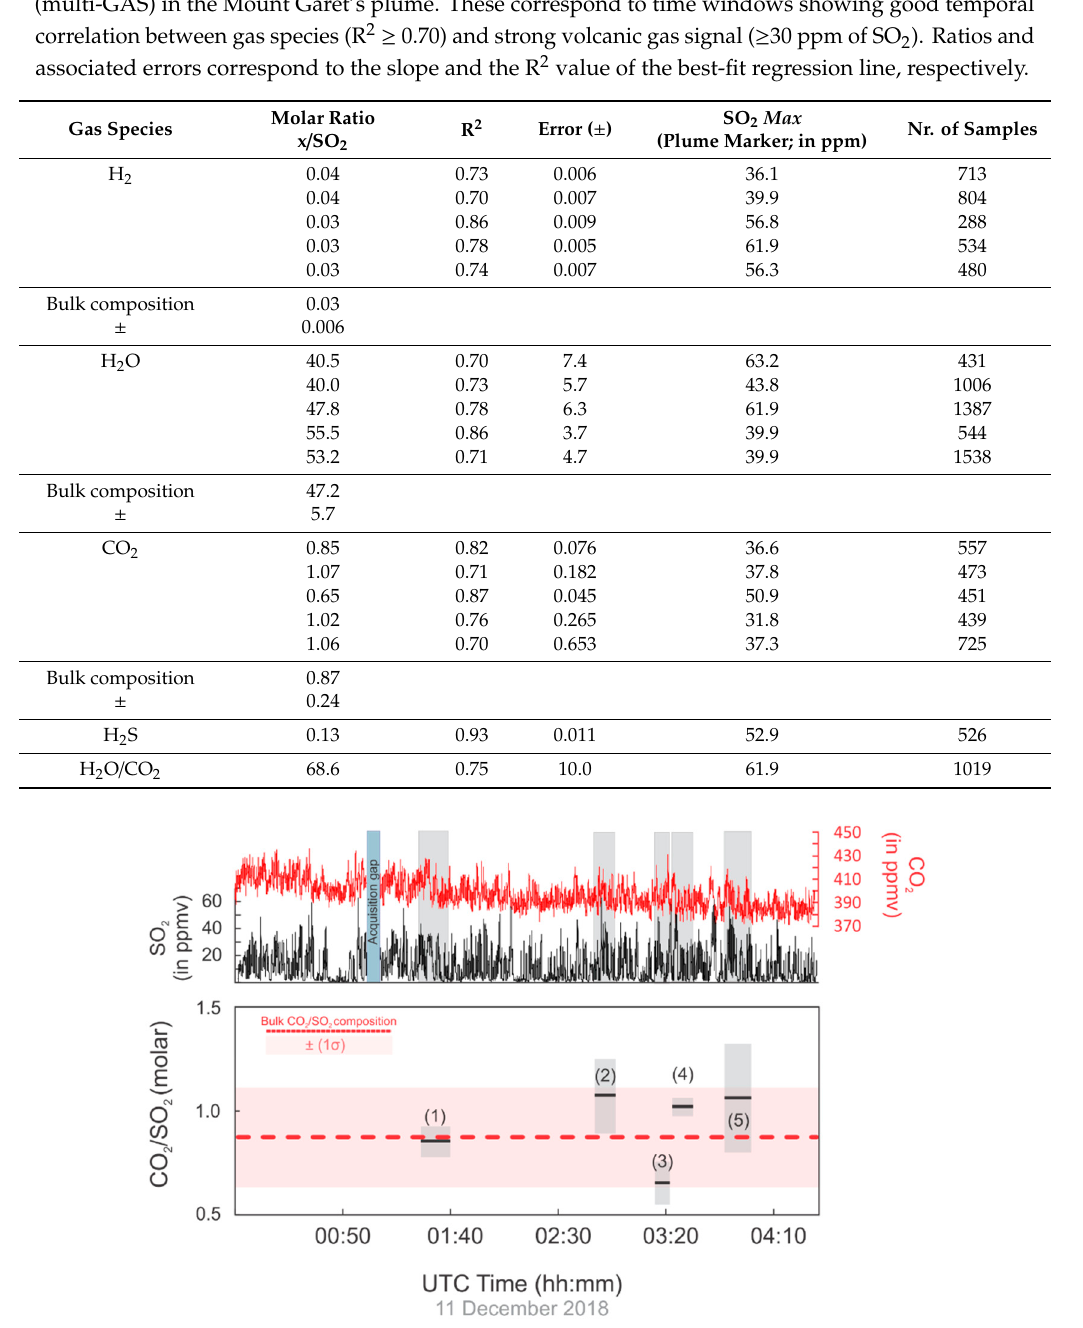
Figure 2. CO 2 / SO 2 mixing ratios estimated across the 4-h survey period. At the bottom, the dash red line represents the regression analysis of all 5 CO 2 / SO 2 ratios (Table 1) combined. SO 2 and CO 2 concentration (in ppmv) time series at the top illustrates plume conditions at which individual ratios were calculated. Note that CO 2 / SO 2 ratio (3) is then shown in Figure 3 for detailed calculation procedure.